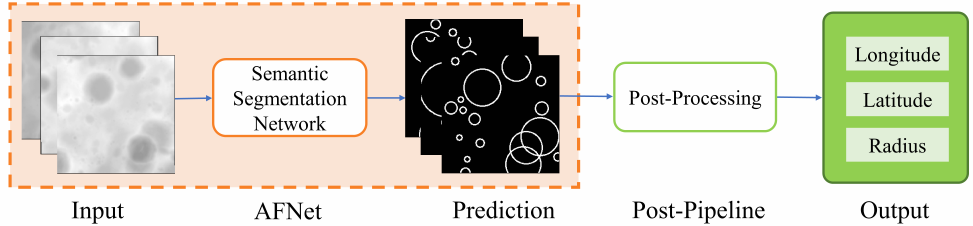
Figure 1. Workflow of two stages used in the crater detection method based on the semantic segmentation network and the crater edge extraction method. The network input is the DEM image. The digital elevation model (DEM) image is first processed by AFNet to recognize crater edges by pixel-level classification. Then, the prediction result of the crater images from network training is processed by a post-processing pipeline based on the match template method to detect the location information and radius size of